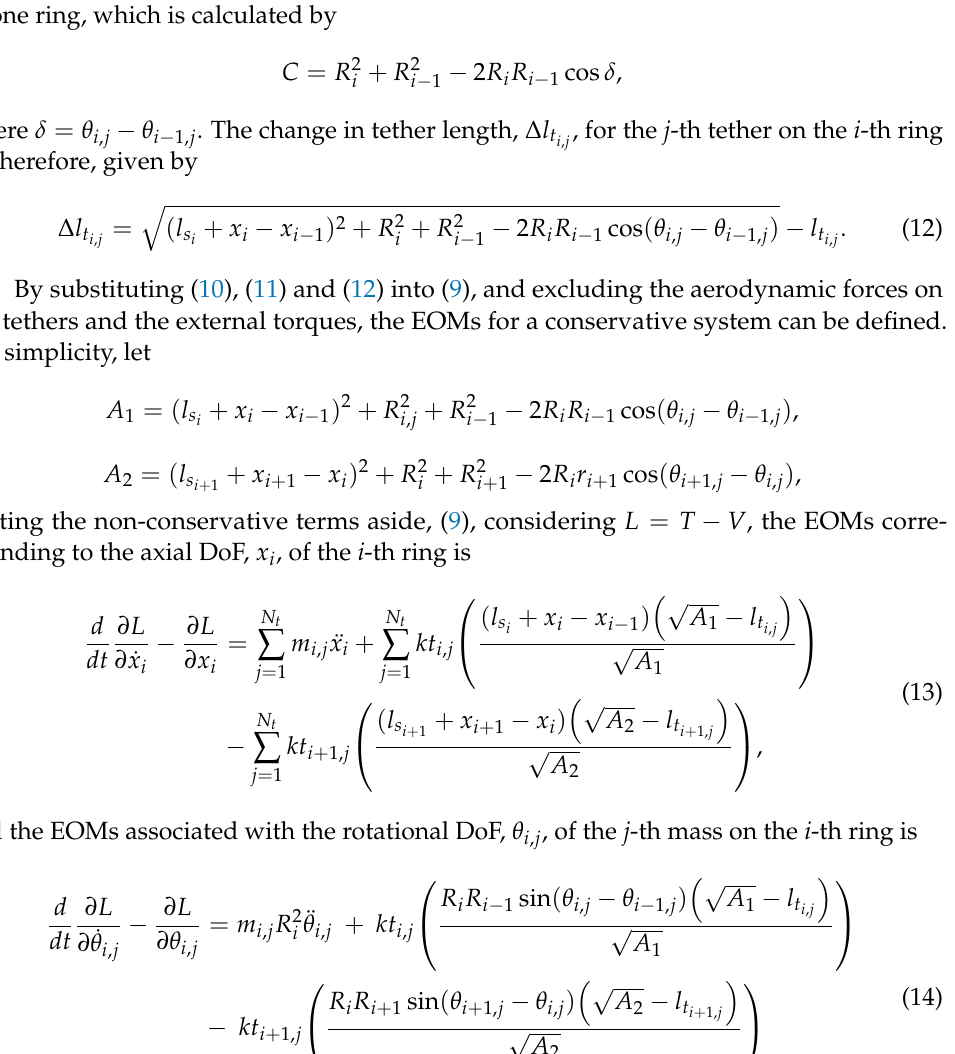
Figure 6. Diagram showing the change in tether length, ∆ l t Length C in Figure 6 defines the distance between the ends of the tether in the plane of one ring, which is calculated